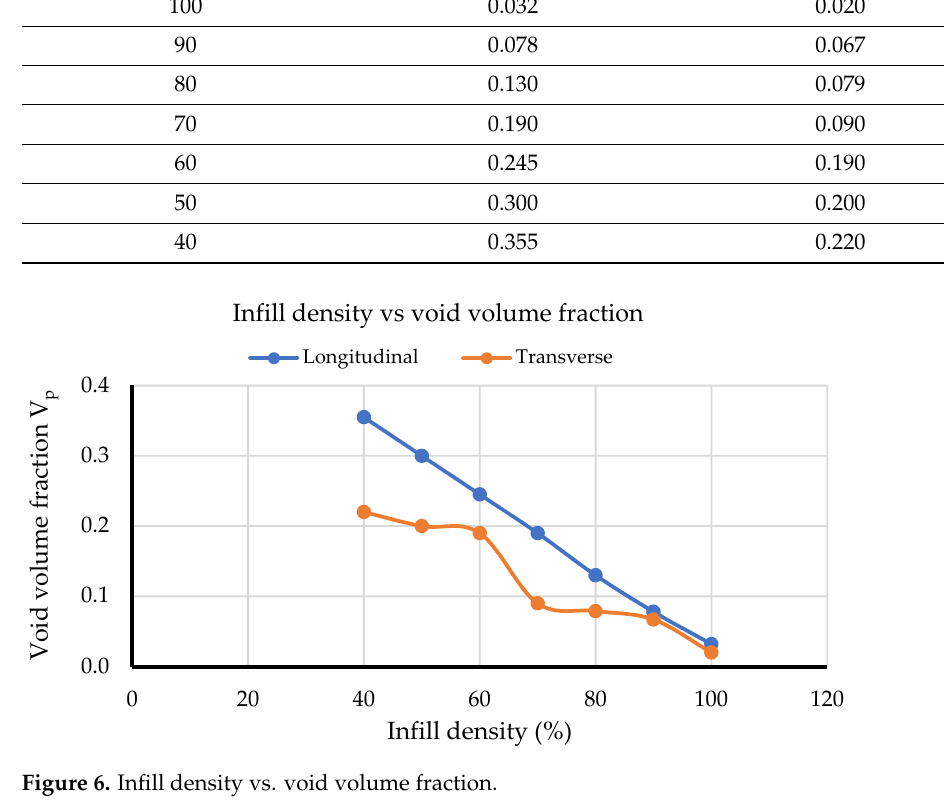
Table 4. Void volume fraction at various infill densities.